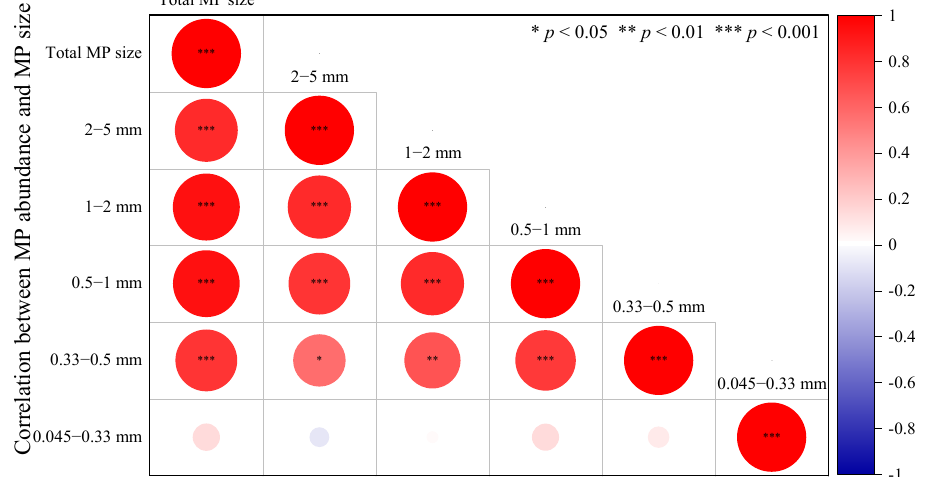
-0.8-0.6-0.4-0.200.20.40.60.81 Figure 5. Spearman correlation coefficients between MP abundance and MP size ( n = 15). Note: * refers to correlations significant at p < 0.05 (two-tailed), ** refers to correlations significant at p < 0.01 (two-tailed), and *** refers to correlations significant at p < 0.001 (two-tailed). 3.4. Quantifying the Inventory of MPs in the Bathing Seawater Affected by the Ebb Tide. The inventory of MPs present in the bathing seawater for each tide was quantified on the basis of the individual area of each block using Equation (1) (Figure 6). The average MP inventory was 3.2 × 10 6 items, ranging from 1.3 × 10 5 to 1.2 × 10 7 items. Overall, the MP inventory was the largest during high tide (66.2%), followed by middle (31.0%), and low tide (2.8%). The MP inventory was distributed differently among different stations under different tidal influences. At stations A, B, and C, the MP inventory was the highest at high tide, accounting for 78.0%, 91.6%, and 89.5%, respectively. The second was the MP inventory at mid tide, and the last was at low tide. The MP inventory at stations D and E was the highest at mid tide, accounting for 59.4% and 91.3%, respectively, followed by the MP inventory at high tide, and the MP inventory at low tide.